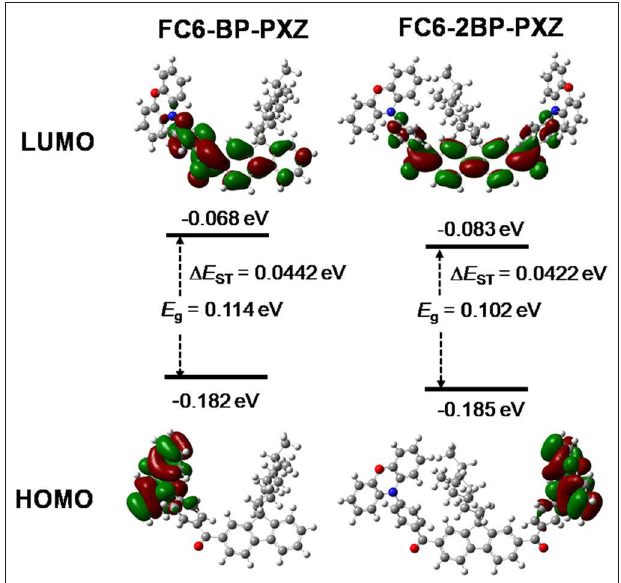
FIGURE 3 | Optimized molecular structures and frontier orbital amplitude plots of FC6-BP-PXZ and FC6-2BP-PXZ, calculated by PBE0 hybrid functional at the basis set level of 6-31G*.